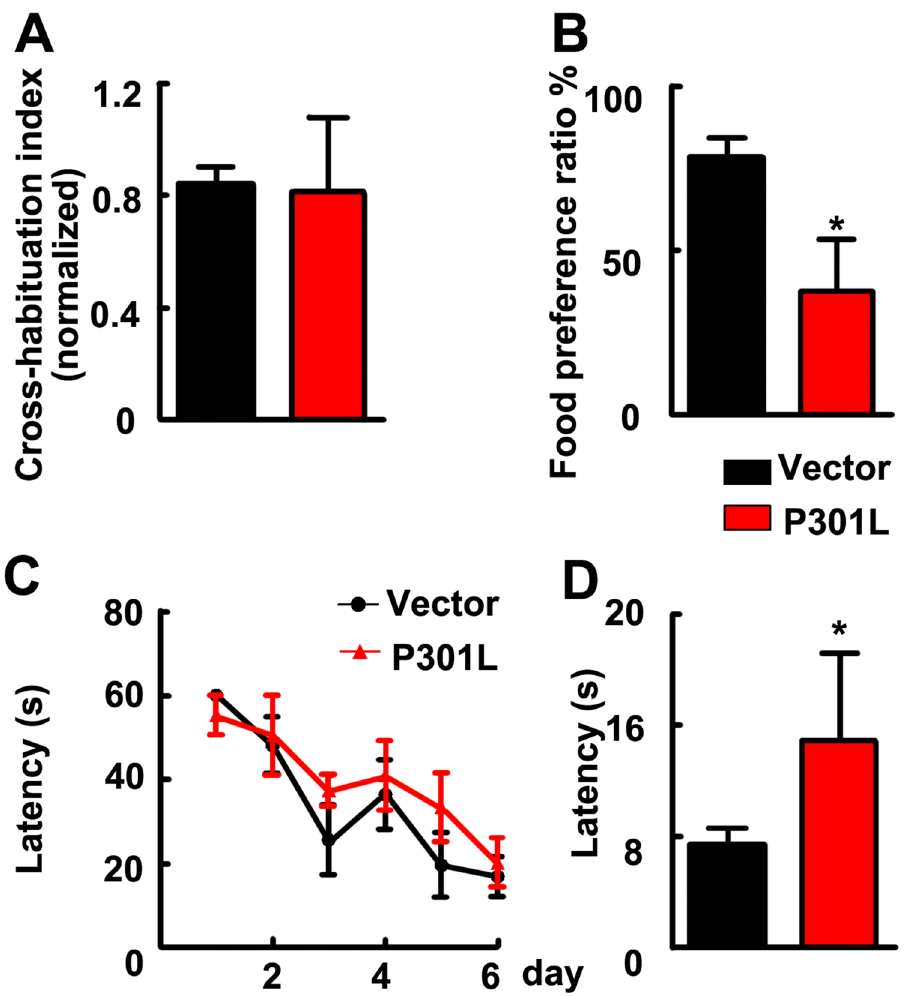
Figure 3. Transduction of P301L hTau in MEC for one month induced hippocampus-dependent memory deficits with an intact olfactory function. ( A ) In odor cross-habituation test, the olfactory function was intact in both groups revealed by cross-habituation index. ( B ) The STFP test showed that the olfactory-dependent memory was attenuate significantly in P301L hTau transduced mice compared to control. ( C ) In the MWM test, escape latency of training indicated that learning capacity of P301L hTau transduced mice kept normal like control mice. ( D ) The probe test showed that the expression of P301L hTau in MEC impaired hippocampal- dependent spatial memory of mice. (vector, n = 8, P301L, n = 11. * p < 0.05). Data were expressed as mean ±